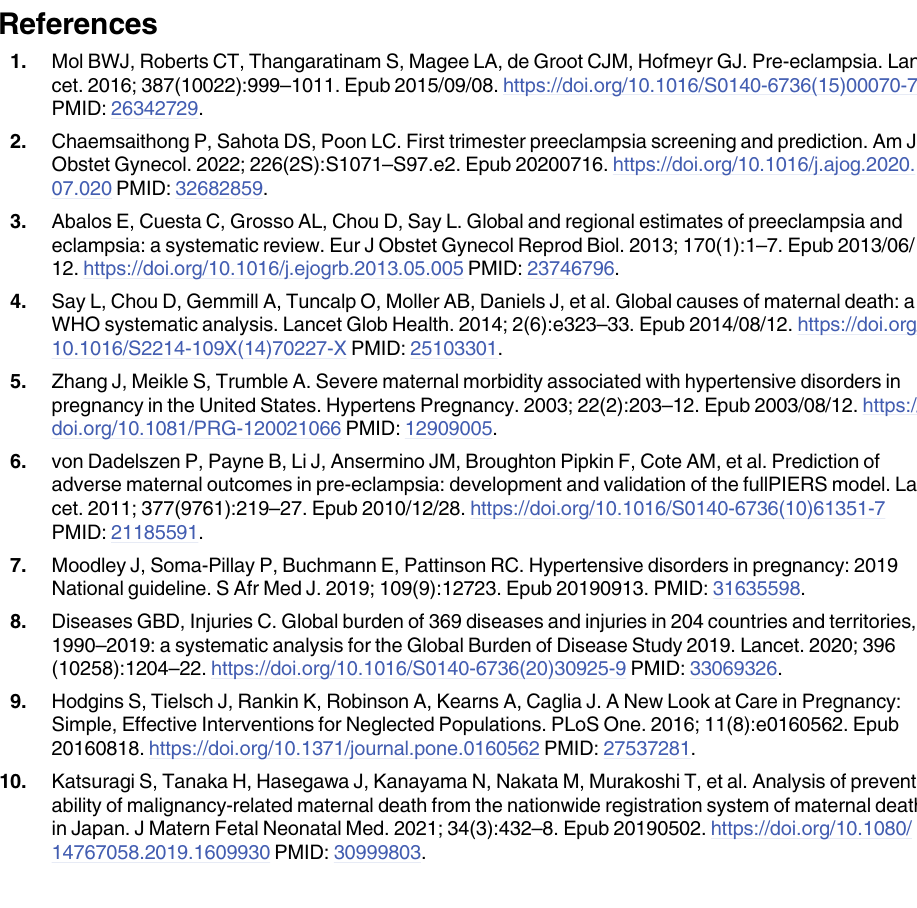
S1 Table. PRISMA-P 2015